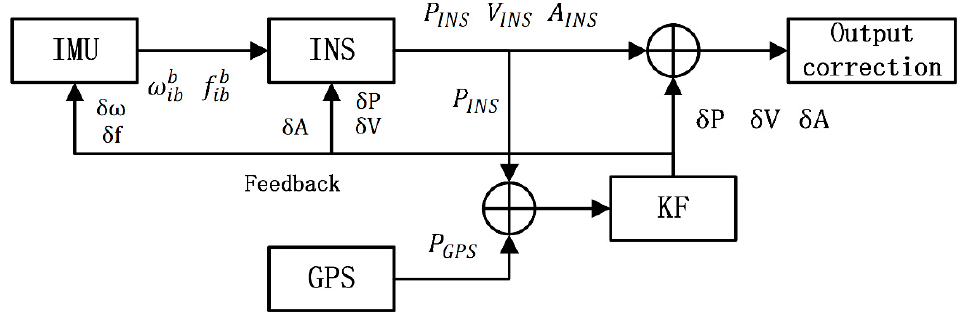
Figure 1. Coupled global navigation satellite system (GNSS) / inertial navigation system (INS) integrated navigation system. KF—Kalman